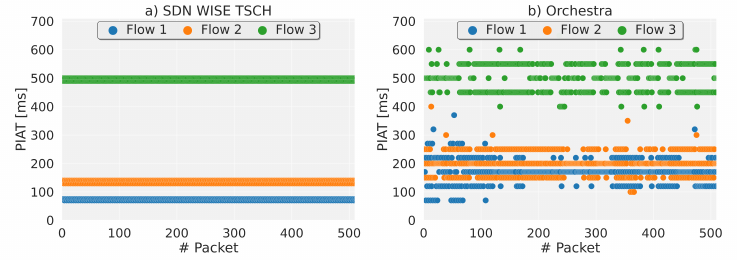
Figure 8. Packet Inter-arrival Time for each Scheduling protocol with multiple data Flows.